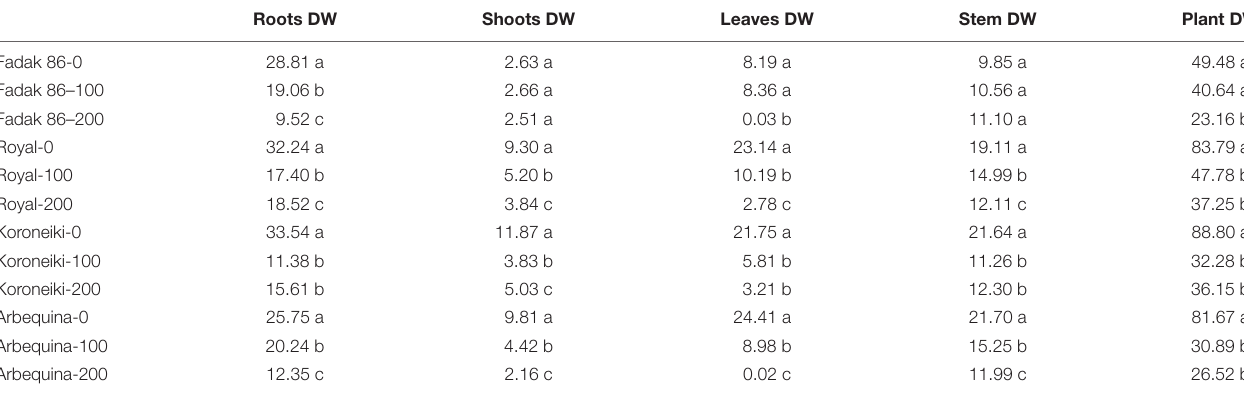
TABLE 4 | Dry weight (DW) (g) of different parts of olive plants treated with 100 and 200 mM NaCl at 240